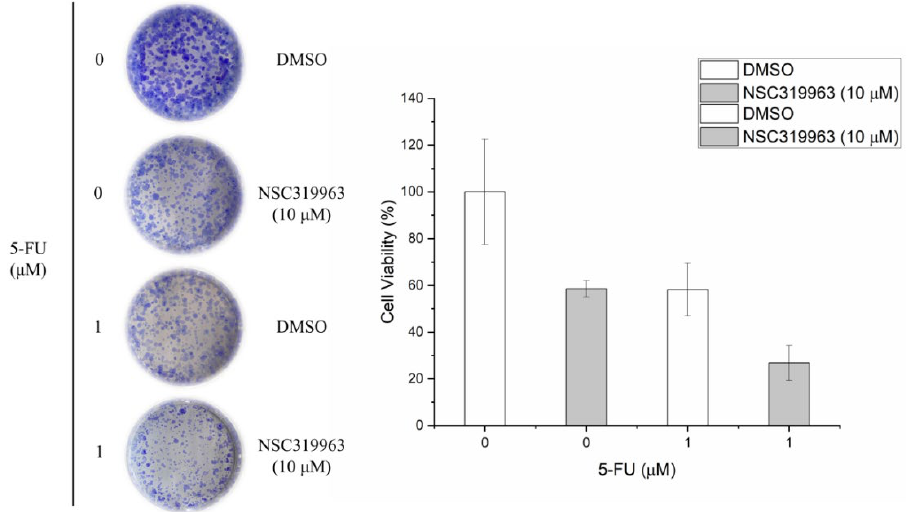
Figure 9. NSC319963 enhances the chemosensitivity of 5-FU in DLD-1 cells. DLD-1 cells were treated with different concentrations of NSC319963 and 5-FU for 12 days. Colony formation was counted and presented as bar graphs. Each column represents the mean ± SD with triplicate experiments.